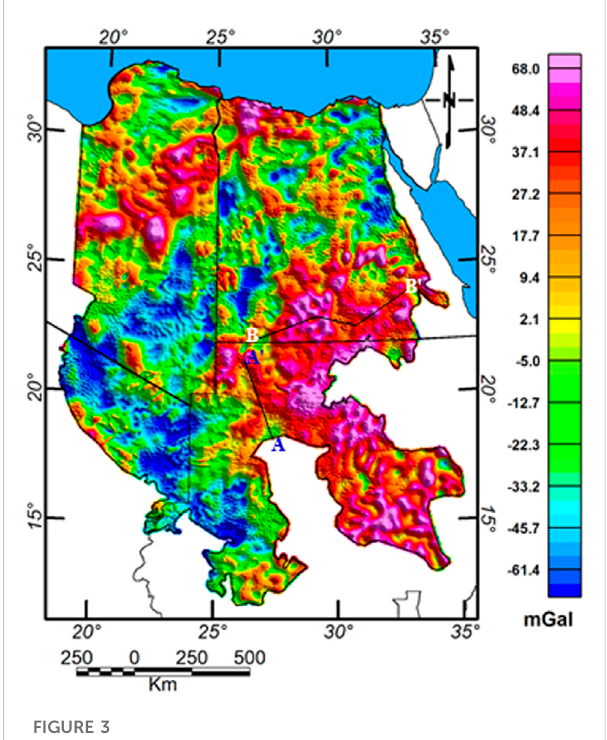
FIGURE 3 High-pass fi ltered gravity anomaly map ( λ < 1,000 km) of the Bouguer gravity anomaly map (Figure 2). Also shown are the locations of AA ’ gravity pro fi le and BB ’ cross section (Figure 18).